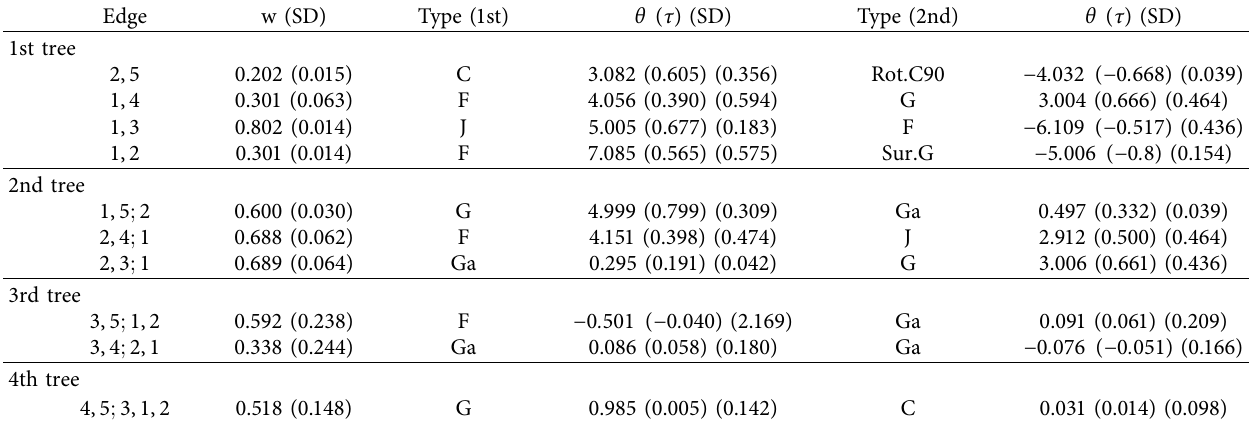
Table 4: Summary of the two-component full R -vine copula mixture model.